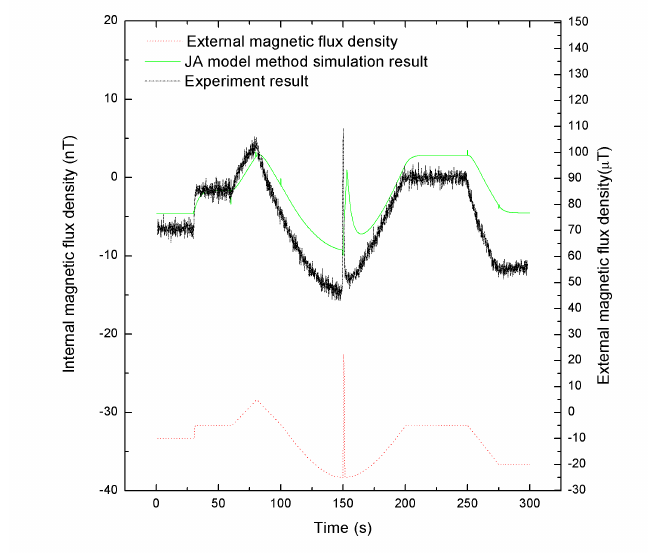
Figure 7. The wave of the MSR at HIT when the external field is arbitrary with a